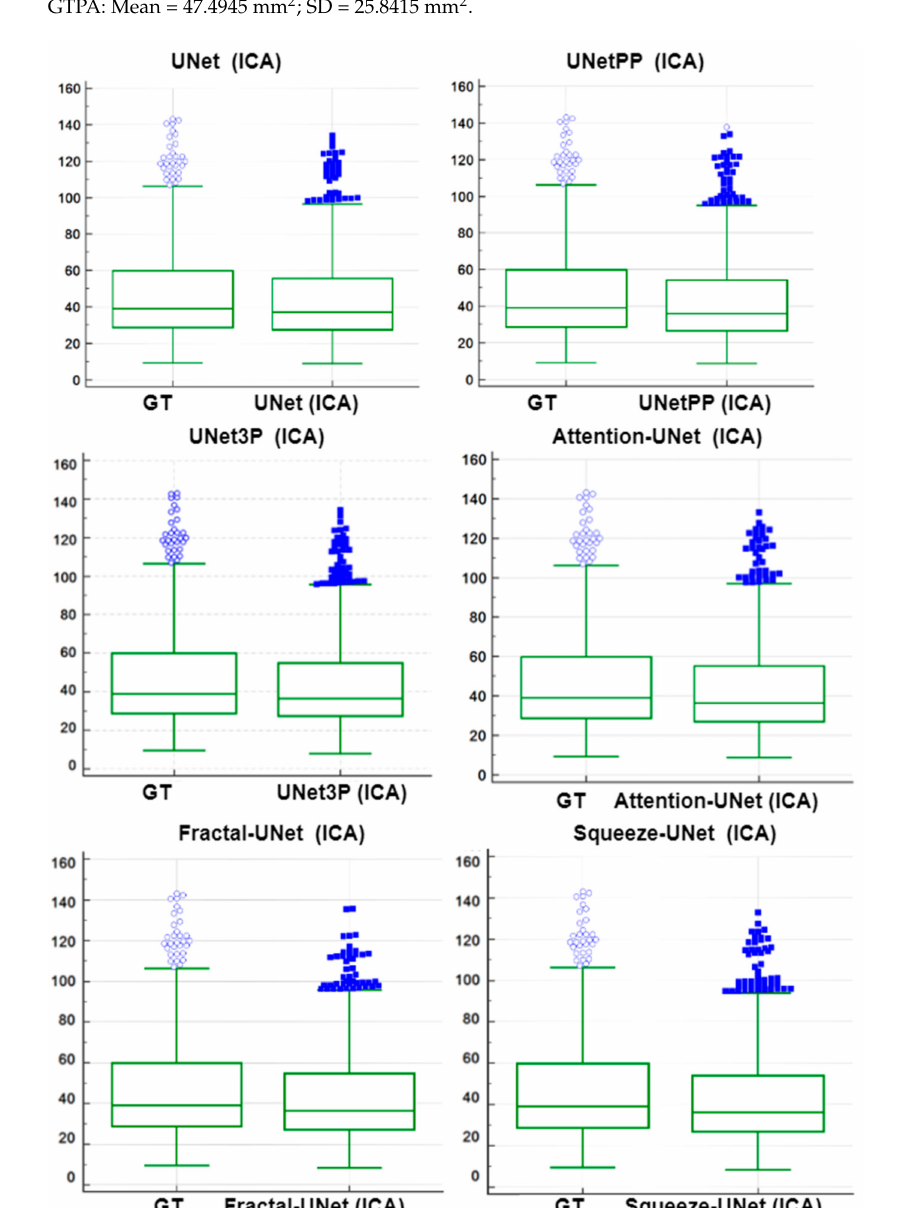
Figure 14. Paired samples t -test Plot for all 6 types of UNet models for ICA DB1